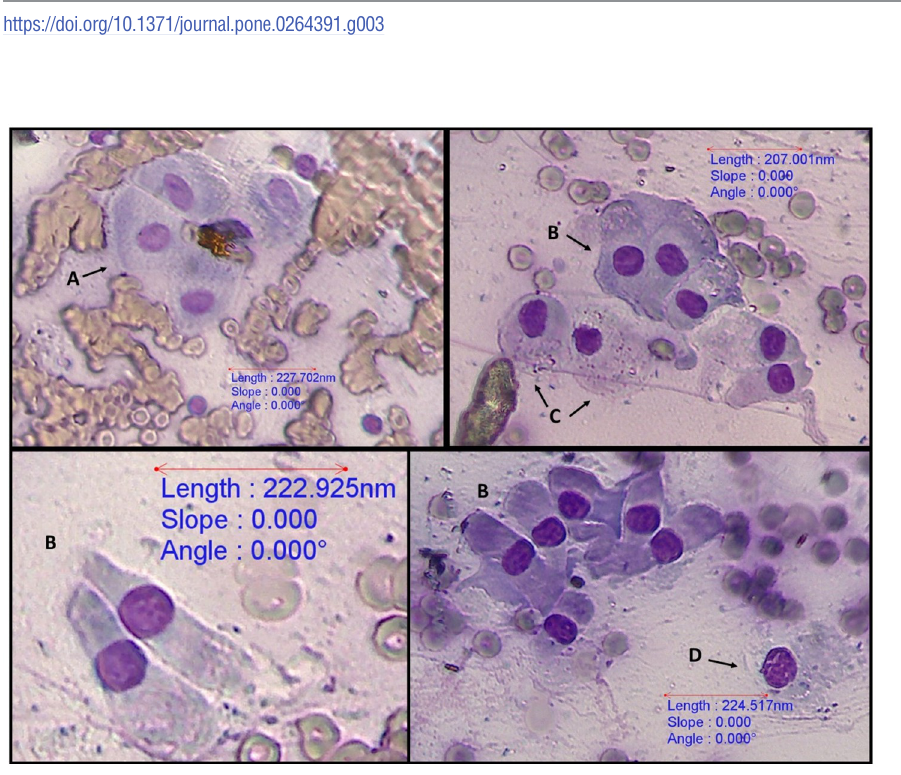
Fig 4. Red blood cells and hepatobiliary cells. 40x, (A) hepatocytes, (B) biliary columnar epithelial cells, (C) mesothelial cells, and (D) cuboidal epithelial cell. Diff-Quik stain, euromex CMEX 5 microscope camera.